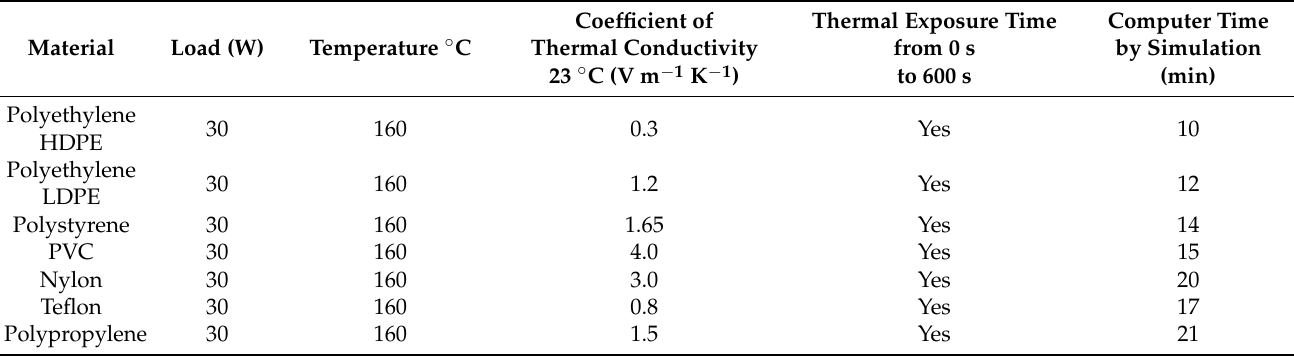
Table 2. Border conditions for